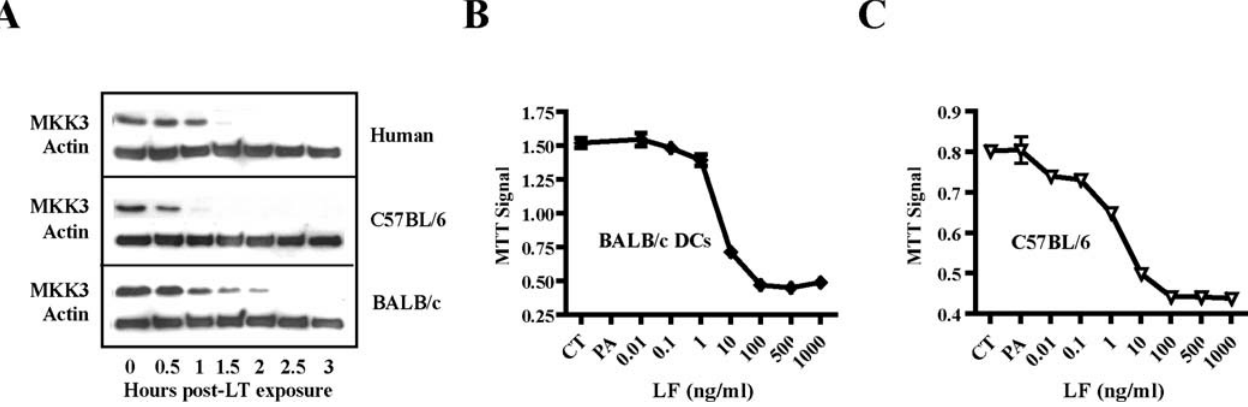
Figure 5. MAPKK Cleavage Kinetics and LT Susceptibility of BALB/c- and C57BL/6-Derived BMDCs (A) MAPKK-3 cleavage occurs at similar rates in murine and human DCs treated with LT (500 ng/ml PA and 250 ng/ml LF), as determined by Western blot analysis using anti-MKK3 and anti-actin (control) antibodies. (B and C) Relative LT susceptibility of BALB/c- (B) and C57BL/6-derived (C) BMDCs. BALB/c and C57BL/6 BMDCs were subjected to PA (500 ng/ml) and varying concentrations of LF. After 4 h (BALB/c DCs) and 72 h (C57BL/6 DCs), cell viability was determined by MTT assays. Representative experiments are shown. DOI: